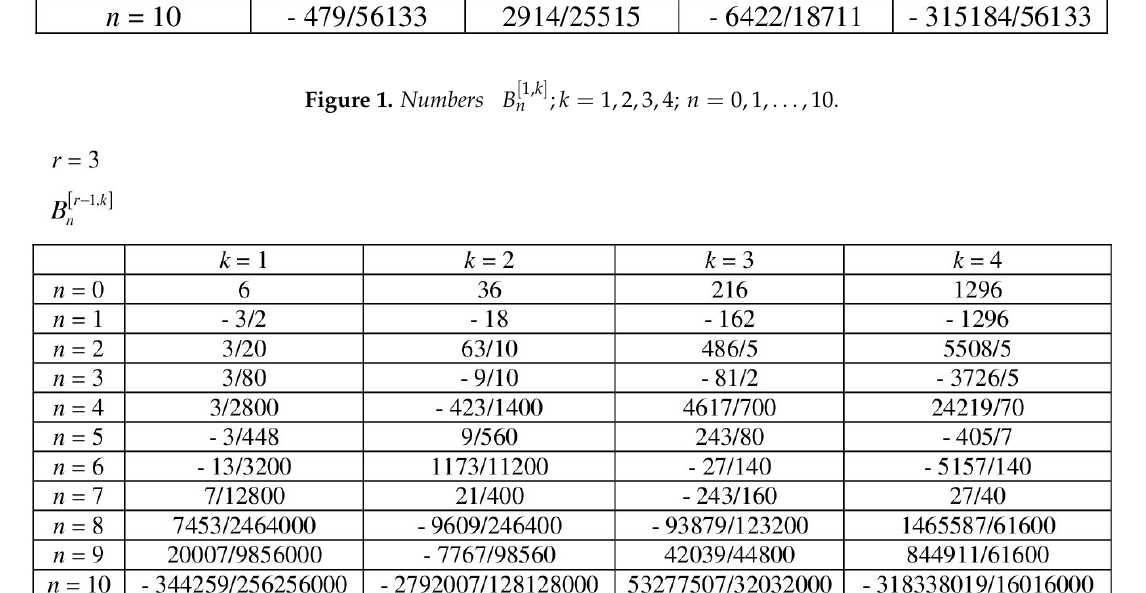
Figure 2. Numbers B